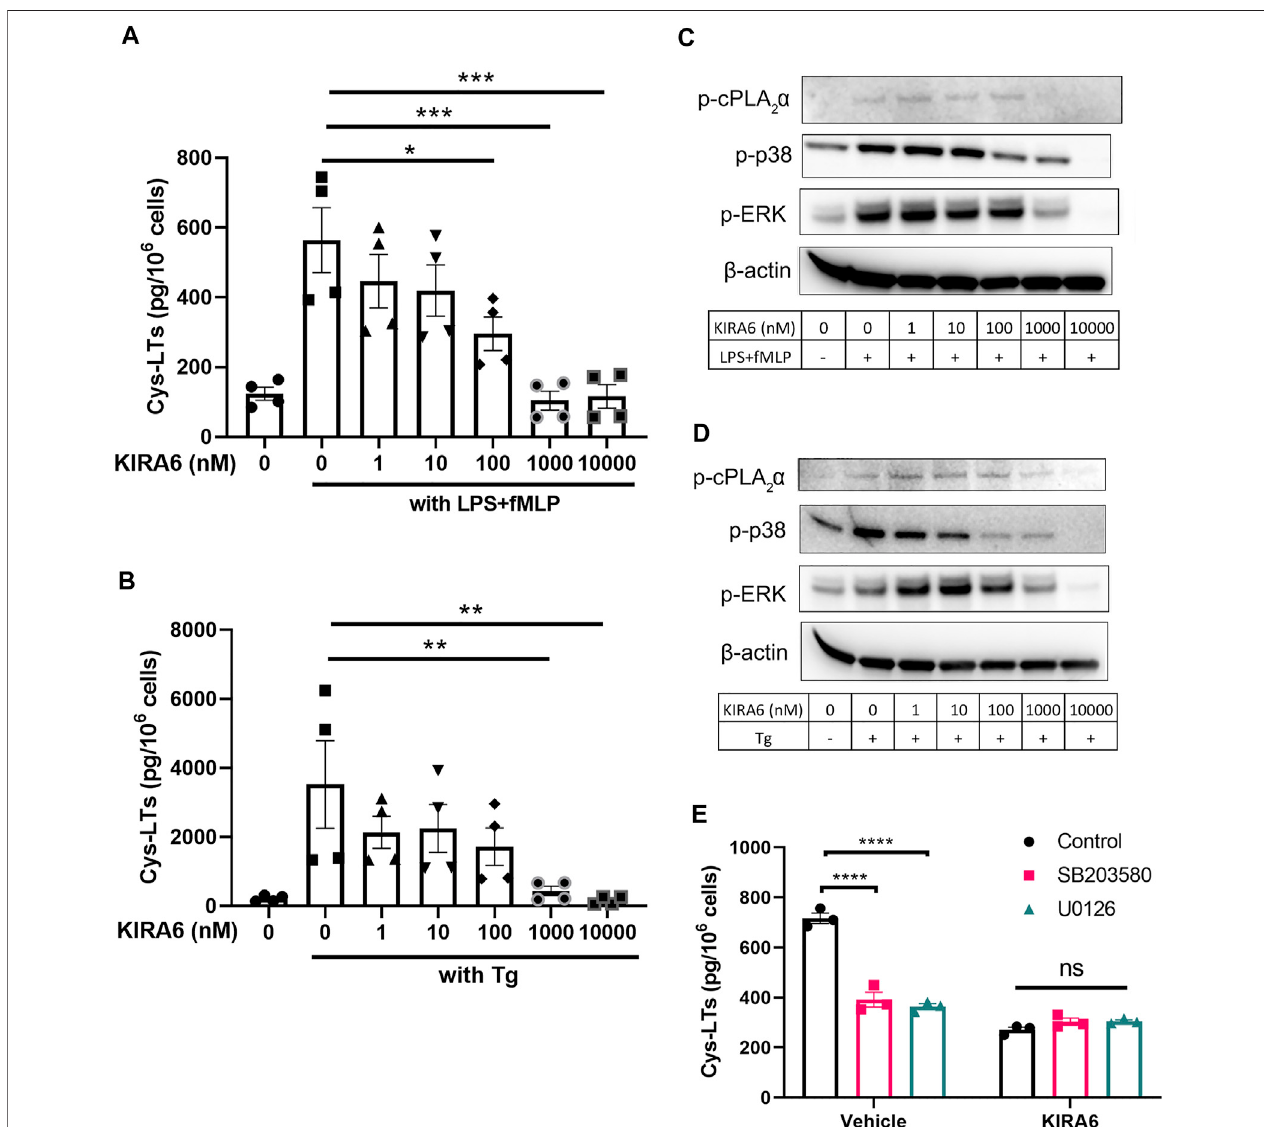
FIGURE 2 | Phosphorylation of p38 and cPLA 2 α is reduced in KIRA6 treated cells (A,B) . MM6 cells were pretreated with vehicle (0.1% DMSO) or different concentrations of KIRA6 for 30 min, followed by challenge with LPS (100 ng/ml, 10 min), and fMLP (5 μ M, 30 min), or Tg alone (1 μ M, 30 min). Cys-LTs in cell supernatants were analyzed by ELISA ( n = 4). (C,D) Phosphorylated cPLA 2 α , p38, and ERK (p-cPLA 2 α , p-p38, and p-ERK) were analyzed by western blot (representativeofthreeindependentexperiments). (E) MM6cellswerepre-treatedwithvehicle(0.1%DMSO)orKIRA6(1 µM)followedbyincubationofSB203580 (10 µM) or U0126 (10 µM) for 30 min. The cells were further stimulated with LPS (100 ng/ml, 10 min) and fMLP (5 μ M, 30 min). Cys-LTs in cell supernatants were analyzed by ELISA ( n = 3). *p < 0.05, **p < 0.01, ***p < 0.001, ****p < 0.0001, ns: no signi fi cance.